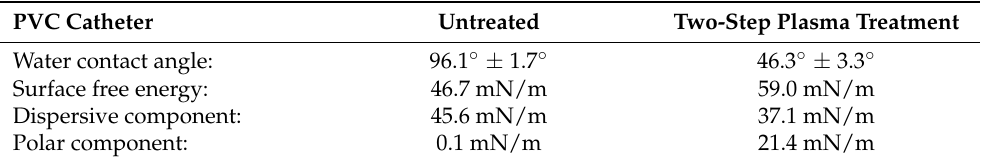
Figure 5. Experimental set-up. Table 3. Wettability, surface free energy (SFE), the disperse and polar components of SFE for PVC catheter.